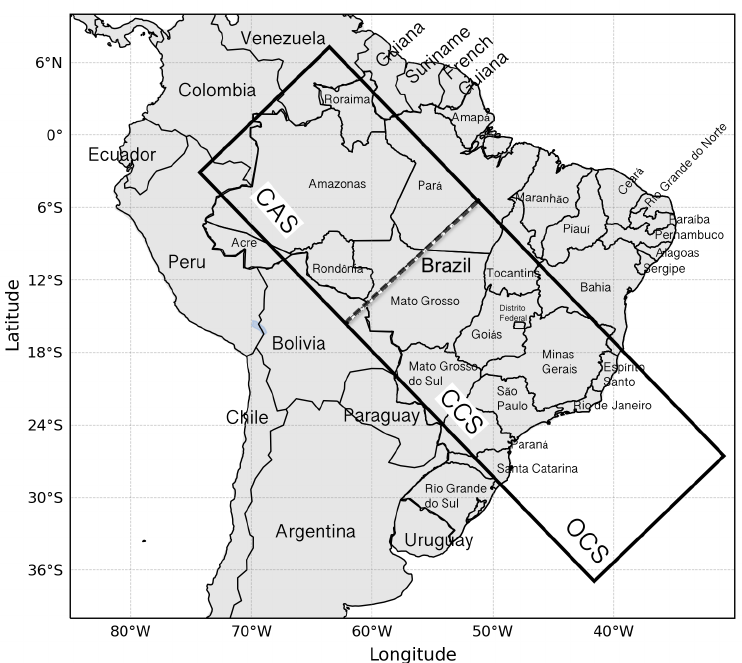
Figure 1. Description of the study area of the average position of the SACZ over SA and its subregions named: Continental SACZ (Amazonian and Coastal) and Ocean SACZ (OCS). In this map, the dotted lines indicate the division of the SACZ Continental